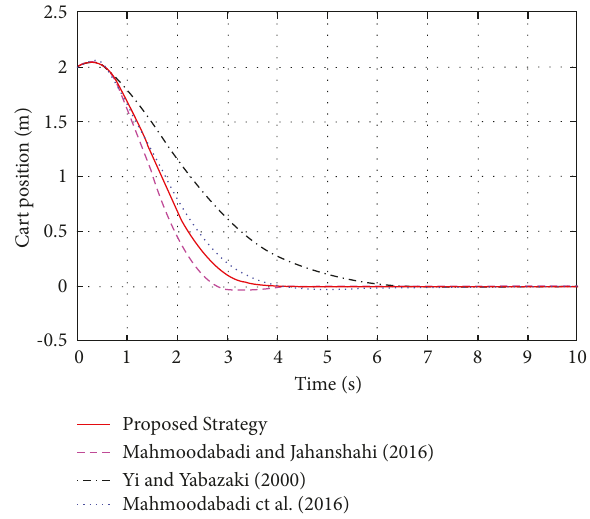
Figure 7: Cart position based on the suggested fuzzy-PID con- troller and the techniques presented in references [28–30].